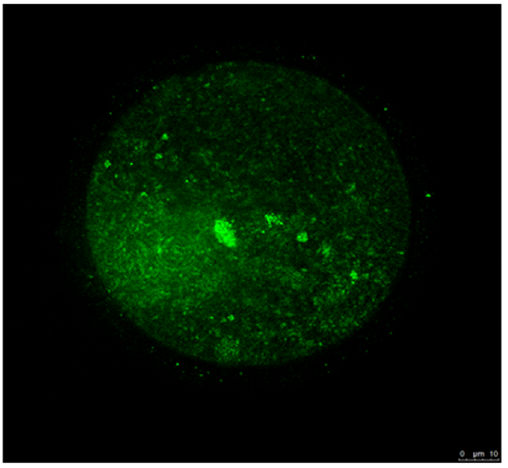
Figure 1. The kinetics of COOH-PLL in mouse oocytes. Mouse oocytes were exposed to PB1(-) supplement with FITC-labeled COOH-